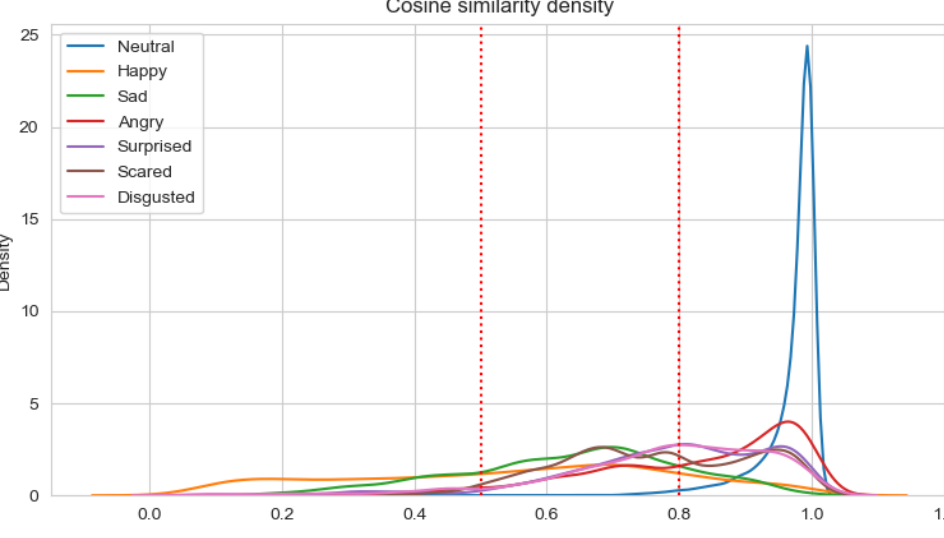
Figure 8. Density plot for Ekman’s emotions with neutral state in Experiment